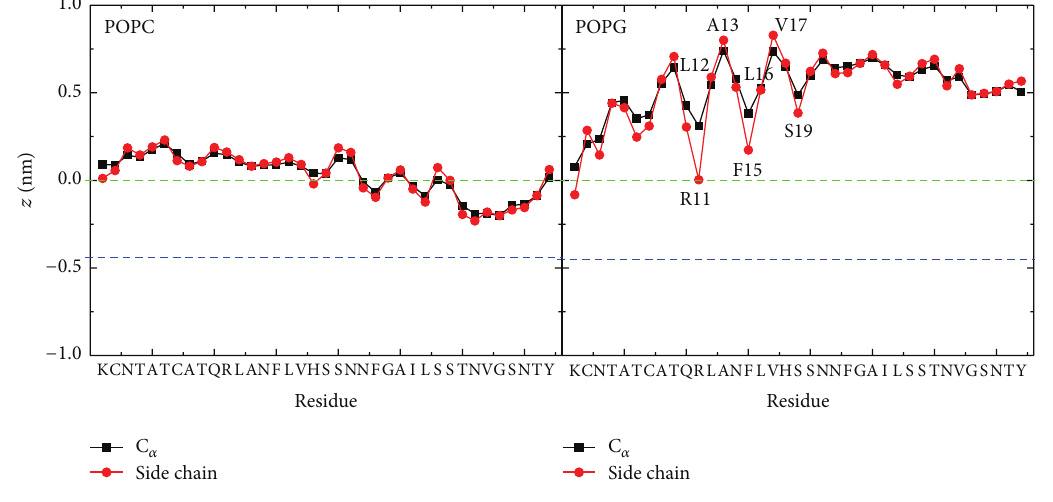
Figure 6: Comparison of averaged 𝑧 -positions of the C 𝛼 atom (black) and the side chain centroid (red) of each amino acid residue at the POPC (left) and POPG (right) membrane surface. The green and blue dashed lines correspond, respectively, to the average 𝑧 -position of phosphorus atoms ( 𝑧 = 0 ) and carbon atoms of the lipid ester